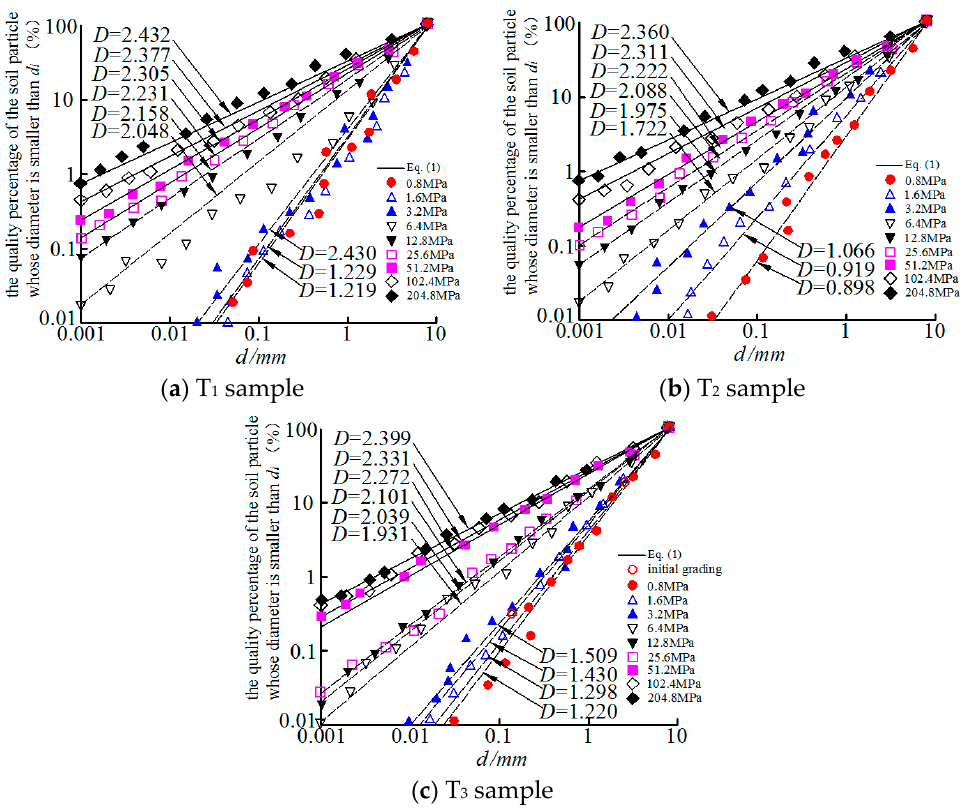
Figure 7. Comparison between results of Equation (1) and measured data of particle size distribution: ( a ) T 1 sample, ( b ) T 2 sample and ( c ) T 3 sample.